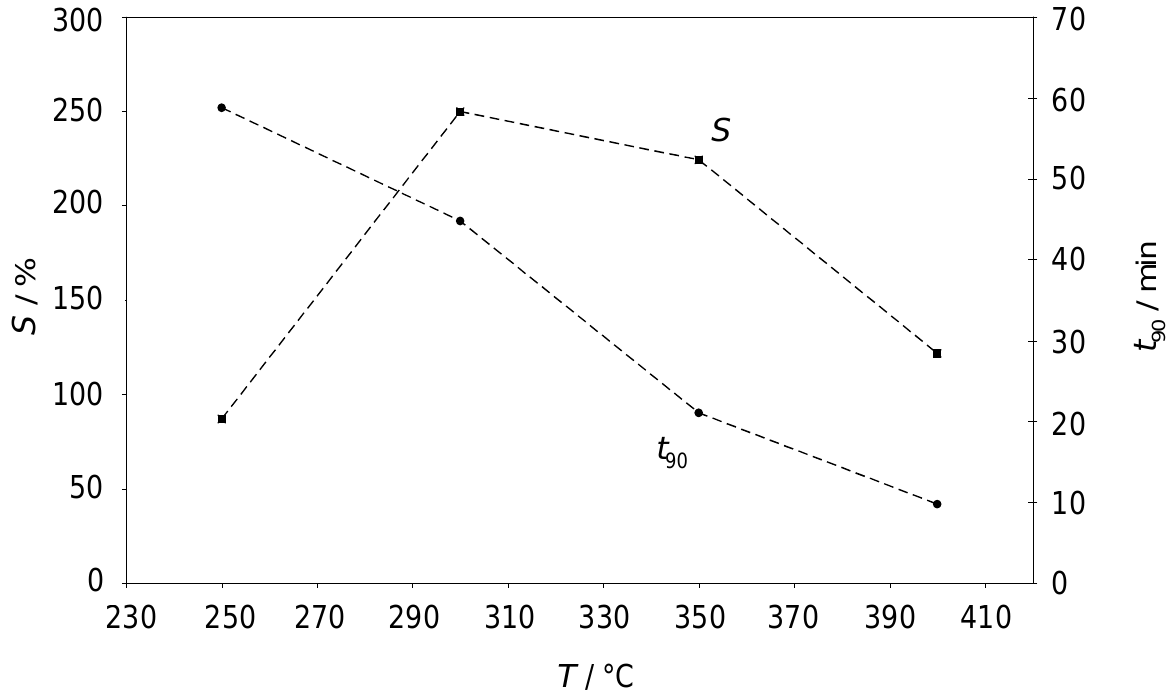
Figure 4. Sensitivity (left axis) and sensor response time (right axis) at a fixed frequency of 3 Hz. Test conditions: base gas 10 % O and 500 ppm C H for two hours, temperature varied from 250 °C to 400 3 8